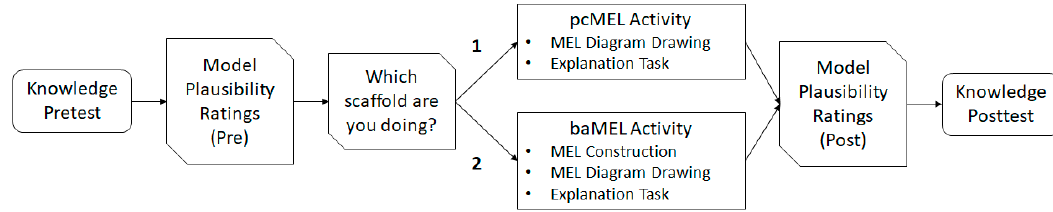
Figure 3. Students first completed the knowledge survey and the plausibility ratings. Then, students completed each pcMEL (1) and baMEL (2) activity over about two regular periods, after which they completed another knowledge survey and plausibility ratings. The only difference between the two MEL activities is that in the baMEL, students were chosen to pick the models and evidence statements.